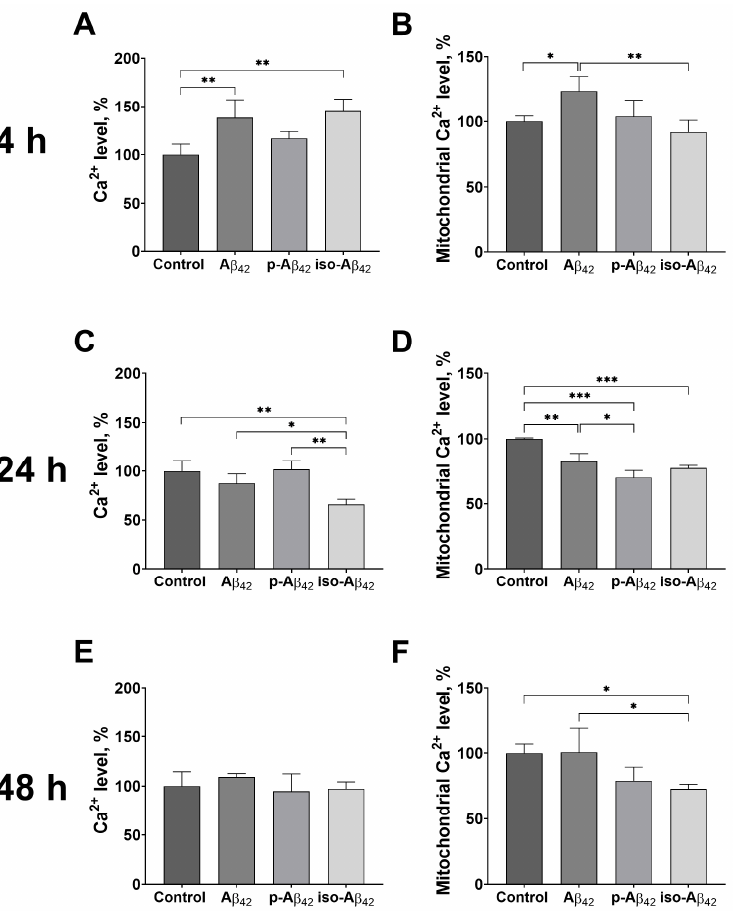
Figure 3. The effects of beta-amyloid isoforms on intracellular and mitochondrial calcium levels in bEnd.3 cells. Cells were incubated for 4 h ( A , B ), 24 h ( C , D ) and 48 h ( E , F ) with 10 µ M of A β 42 , p-A β 42 and iso-A β 42 . Flow cytometry was used to analyze changes in intracellular calcium ( A , C , E ) and mitochondrial calcium ( B , D , F ). All parameters were normalized to control. The values in the control samples were taken as 100%. The mean ± SD in 3 independent experiments in triplicates is shown in the figure. The statistical difference between experimental groups was analyzed by one-way analysis of variance using the post hoc Tukey test for multiple comparisons. *— p < 0.05, ** — p < 0.01 and ***— p < 0.001.